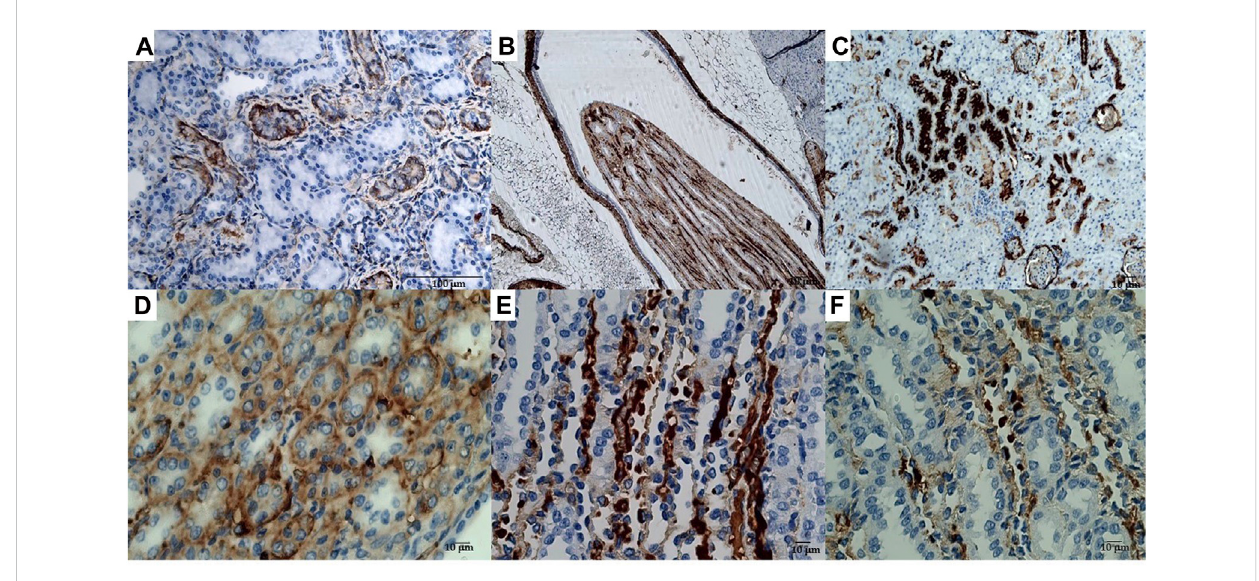
FIGURE 3 (A) Immunohistochemical reactions of the rat kidney tumor sections to mAbs: (A) vimentin, bar = 100 μ m, 20X; (B) calponin, bar = 10 μ m, 10X; (C) CD10, bar = 10 μ m, 10X; (D) CD44, bar = 10 μ m, 40X; (E) Ki67, bar = 10 μ m, 10X, and (F) p53, bar = 10 μ m,